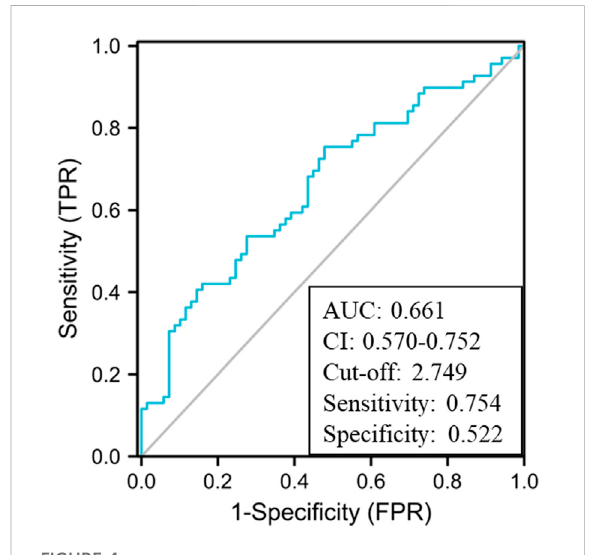
FIGURE 4 AUROC analysis of serum HMGB1 levels in predicting the development of AKI in the post-matching HBV-ACLF cohort during the 90-day follow-up period (AUROC, area under the receiver operating characteristic curve; HBV-ACLF, hepatitis B virus-related acute-on-chronic liver failure; AKI, acute kidney injury; HMGB1, high-mobility group box